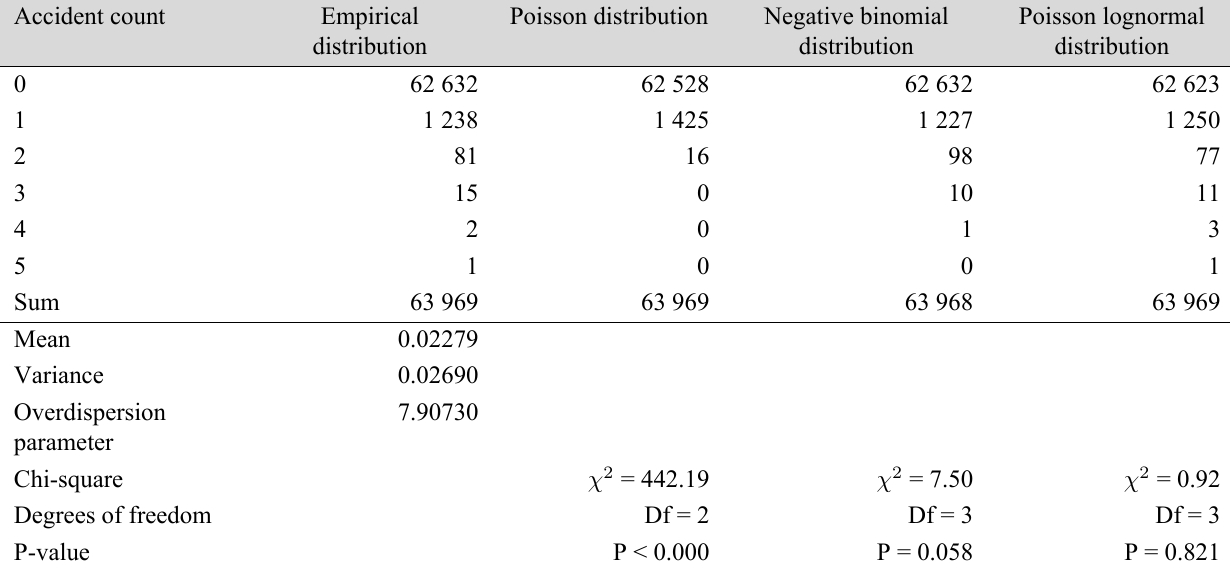
Table 3 Distribution of accidents between curves and goodness-of-fit to theoretical